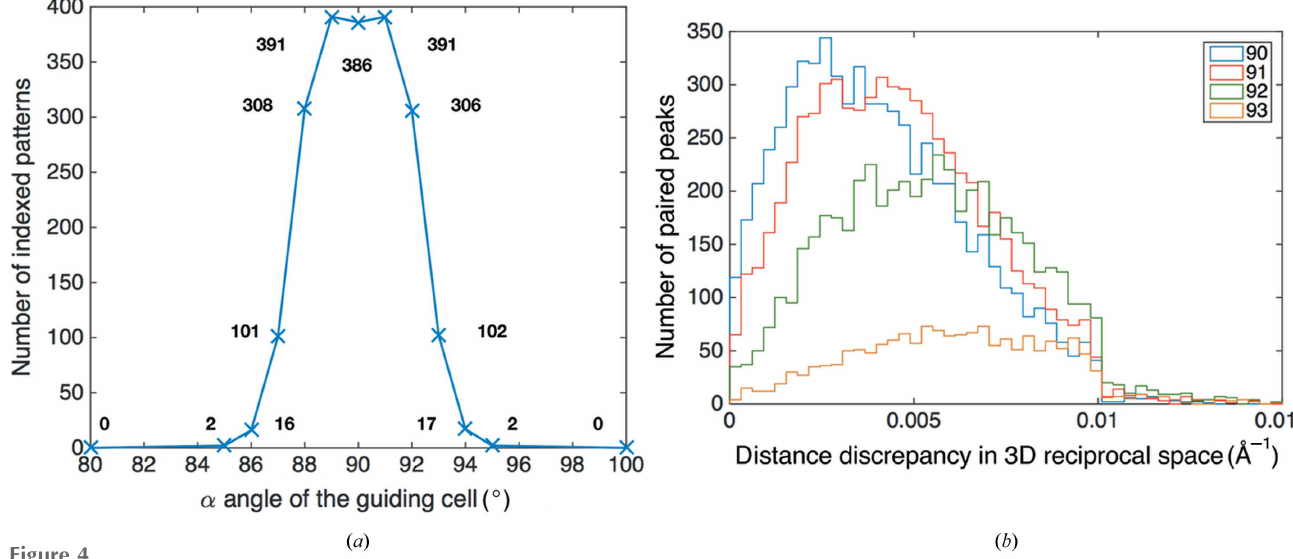
Figure 4 The effect of inaccurate guiding unit cells on SPIND indexing rates and peak-prediction accuracy demonstrated on simulated I3C snapshot diffraction patterns. ( a ) Number of indexed patterns as a function of the (cid:3) angle of the guiding cell ( (cid:3) = 90 (cid:5) is nominal). ( b ) Distribution of distance discrepancy in three-dimensional reciprocal space between found and predicted peaks for matched peak pairs using guiding cells with different (cid:3) angle values. The legend shows the (cid:3) angle of the guiding cell. The center of the distribution shifts to larger values as (cid:3) deviates further from the nominal value of 90 (cid:5) . The same trend was observed for values of (cid:3) < 90 (cid:5) (omitted for clarity). The results demonstrate the robustness of the algorithm to the lattice inhomogeneity, a wide tolerance range for the guiding-cell constants and low false-positive indexing rate when the target lattice cell is clearly distinguishable from the guiding cell. The indexing rate can be used as an indicator for the accuracy of the reference unit cell.